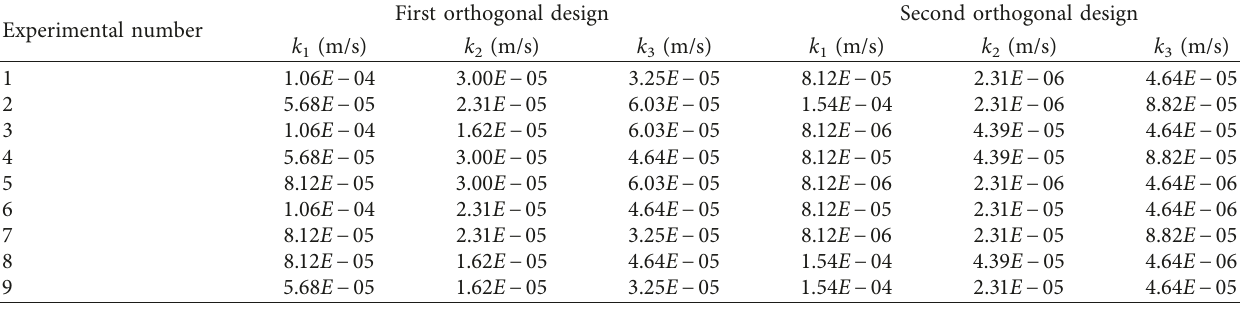
Table 2: Orthogonal design table of permeability coefficients.